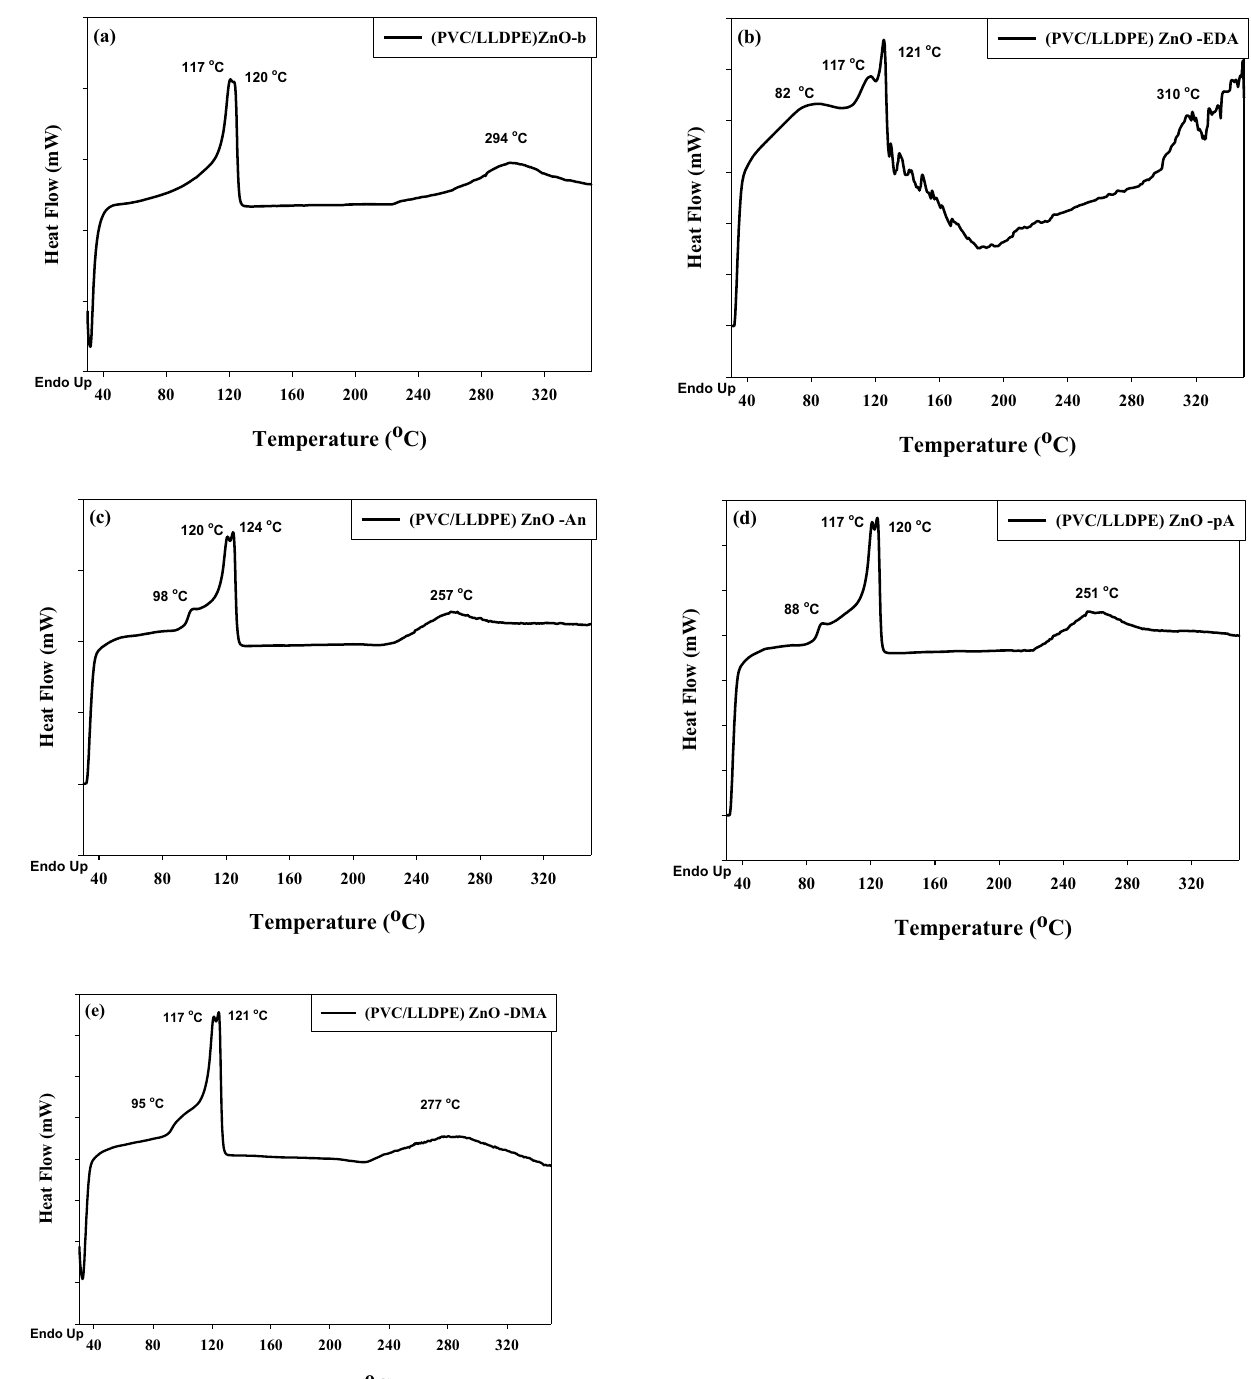
Figure 6. The DSC thermograms of aminated modified PVC in